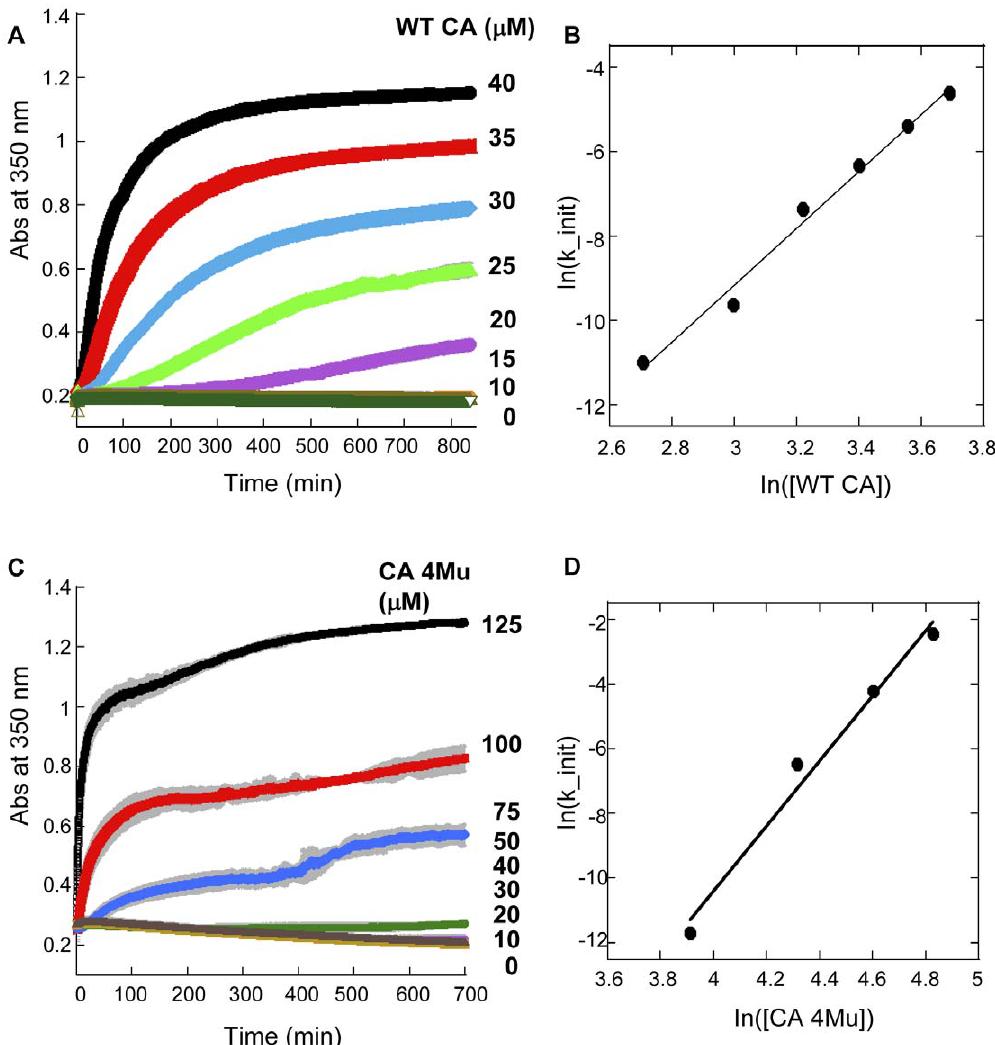
Figure 3. Polymerization kinetics of (A) full-length wild type capsid (WT CA) and (C) mutant capsid [A14C,E45C,W184A,M185A] monomer (CA 4Mu). Assembly reactions were induced by 2-fold dilution of capsid protein into buffer containing 50 mM sodium phosphate (pH 7.5), 4 M NaCl at 25 u C. The increase in samples turbidity (absorbance at 350 nm) due to the formation of large oligomeric structures was plotted as a function of time. Final concentration of capsid protein in reaction is depicted on the right side of the kinetic traces. The data points represent an average of three determinations with standard deviation shown as grey bars. The dependence of the initial rate of capsid polymerization is plotted against the concentration of ( B ) WT CA and ( D ) CA 4Mu monomer. The initial rate was calculated from the slope of the linear phase of the polymerization curve.